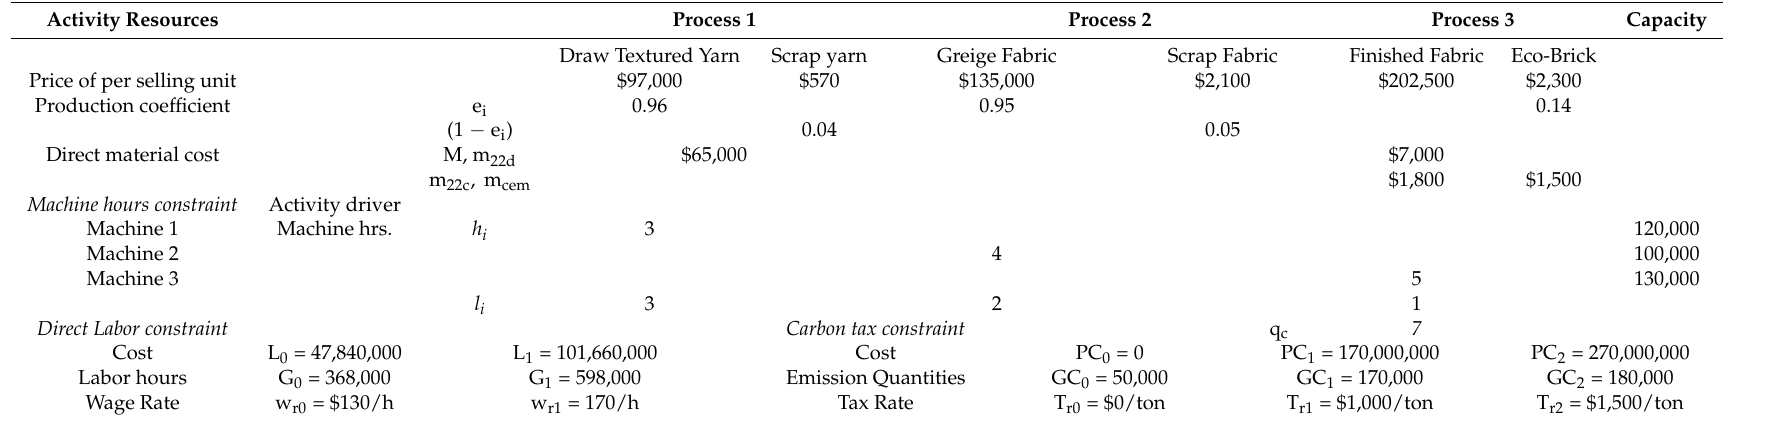
Table 1. Example data.